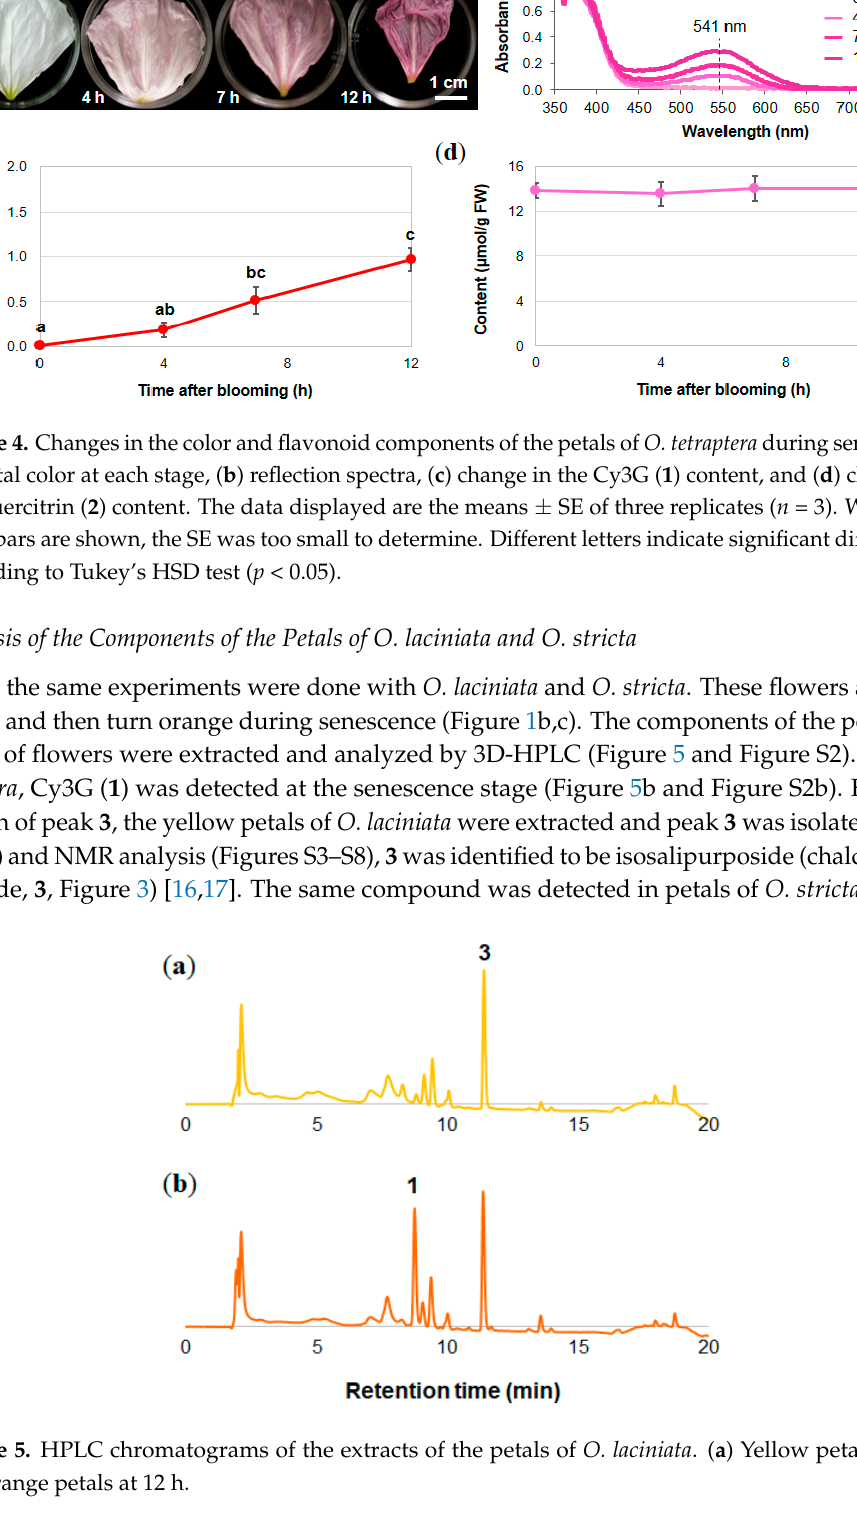
Figure 6. Changes in color and flavonoid components of the petals of O. laciniata during senescence. ( a ) Petal color at each stage, ( b ) change in the Cy3G ( 1 ) content, and ( c ) change in the isosalipurposide ( 3 ) content. The data shown are the means ± SE of three replicates ( n = 3). Where no error bars are shown, the SE was too small to determine. Different letters indicate significant differences according to Tukey’s HSD test ( p < 0.05). According to the well-established flavonoid biosynthetic process [8–11,23], anthocyanins and flavonols are produced via a divergent pathway. Dihydroflavonol is the common precursor in the synthesis of both anthocyanidins by dihydroflavonol reductase (DFR) and flavonols by flavonol synthase (FLS) [10,11]. Since the content of 2 did not change during the experiment, 2 may not be involved in the Cy3G biosynthesis. In the case of chalcone 3 , its content increased in a similar way to